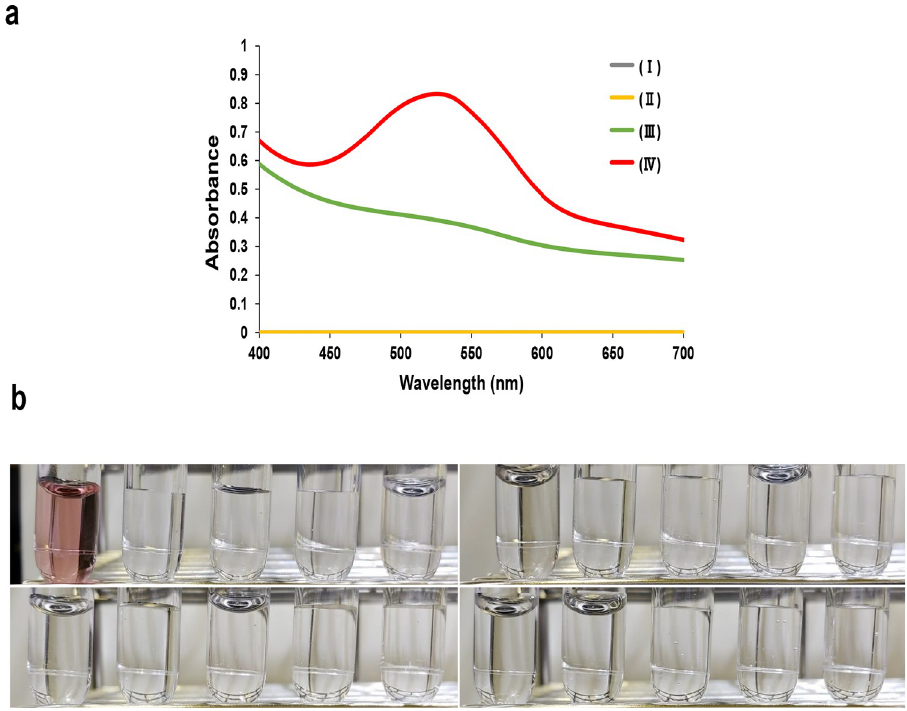
Fig 2. Color changes and absorption spectra of Trp in water with MSG. (a) Absorption spectra of Trp color reaction with different reaction solutions: (I) reagent blank (0 mg/L of Trp with 200 g/L of MSG, 10% HCl and 3% NaOCl � 5H 2 O), (II) 100 mg/L of Trp with 200 g/L of MSG and 10% HCl, (III) 100 mg/L of Trp added with10% HCl and 3% NaOCl � 5H 2 O, and (IV) 100 mg/L of Trp with 200 g/L of MSG, 10% HCl and 3% NaOCl � 5H 2 O. (b) Color reaction for 100 mg/L of 20 standard amino acids with 200 g/L of MSG, 10% HCl, and 3% NaOCl � 5H 2 O. From upper left to right: Trp, Ser, Gly, Ala, Leu, Arg, Met, His, Thr, and Ile. From lower left to right: Pro, Phe, Lys, Val, Cys, Gln, Glu, Asn, Asp, and Tyr.